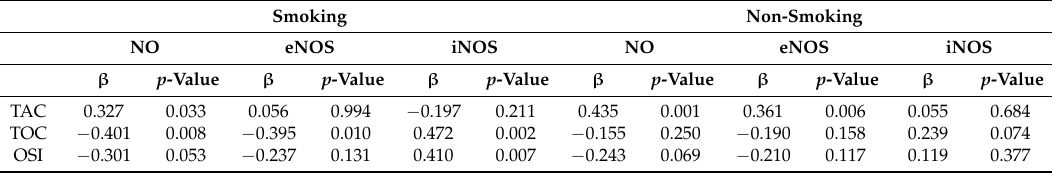
Table 4. Relations between studied nitric oxide parameters and oxidative stress markers in the subgroups of smoking (n = 42) and non-smoking pregnant women (n = 57).